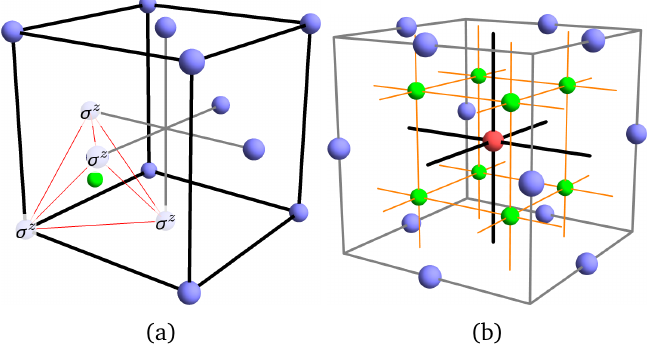
Figure 4: Gauging planar symmetry on FCC lattice. (a) A minimal symmetric cou- pling term: a product of four σ z at the corners of the red tetrahedron. A gauge field τ (green sphere) is placed at the center of tetrahedron. Within the above cube, there are eight tetrahedra (one for each corner of the cube) and gauge fields. The gray lines form the dual lattice. (b) The red vertex is involved in the eight minimal coupling tetrahedron terms centered at the green spheres. The gauge symmetry term is thus a product of a σ x at the red sphere and eight τ x on the green spheres. The product of the eight minimal coupling tetrahedron terms is the identity. The corresponding flux term is a product of eight τ z on the green